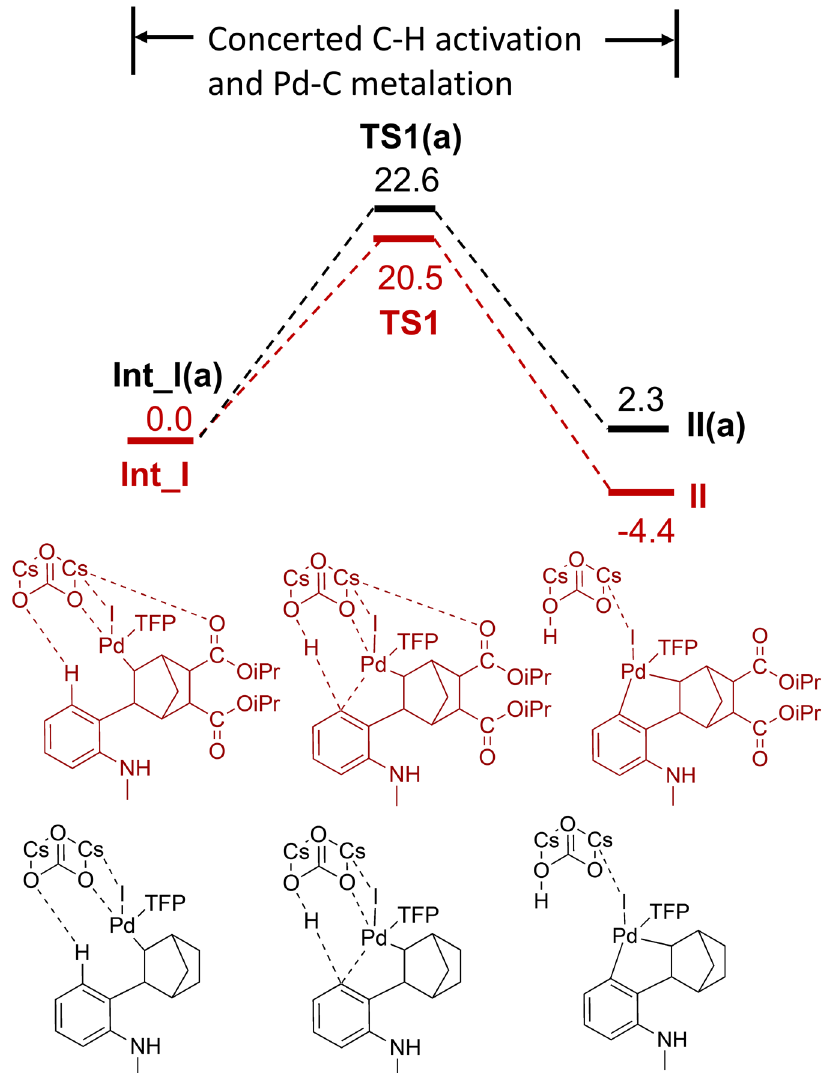
Fig. 9 Computed free energy pro fi le of Int_I → TS1 → II. Intermediates and transit states with 5,6-diCOO i Pr were illustrated in dark red, while unsubstituted ones were illustrated in black. The energies are given in